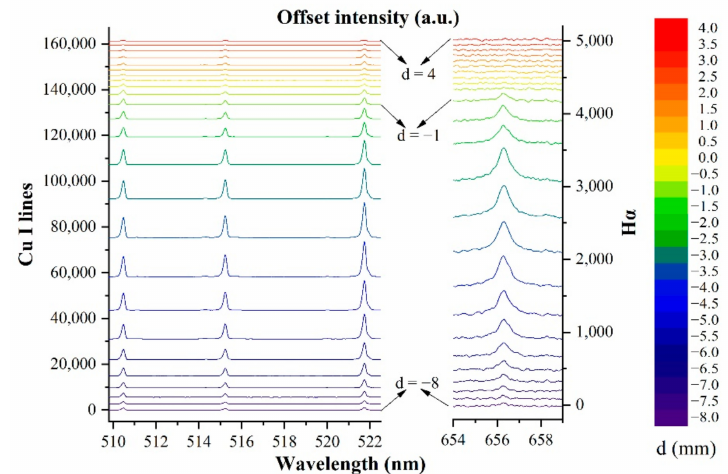
Figure 3. The plasma spectrum of the three Cu(I) lines at different d values (pulse energy is 55 mJ).